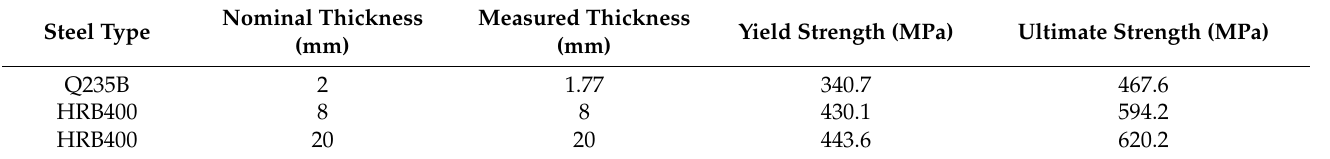
Table 2. Strengths of steel plate and steel bars.